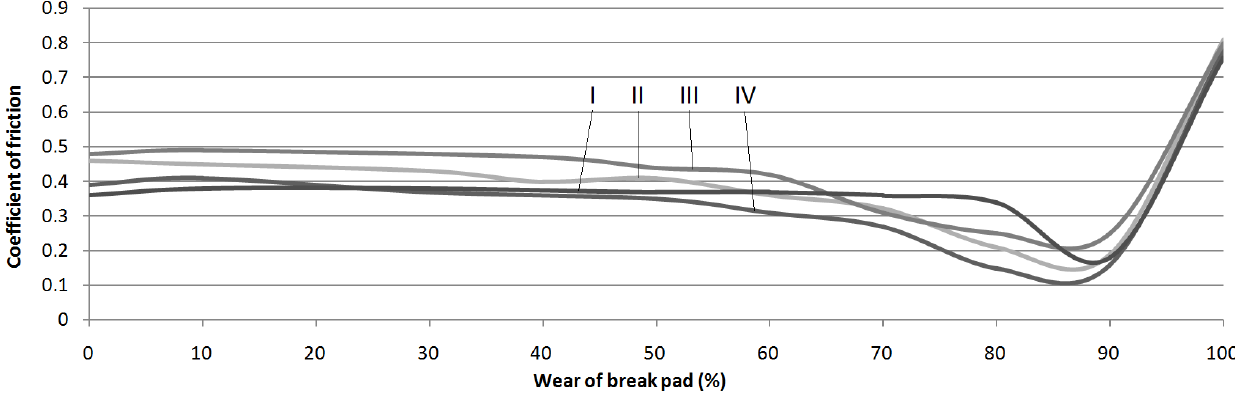
Figure 10. Results of calculations of the coefficient of friction of samples obtained from brake pads at various degrees of wear.